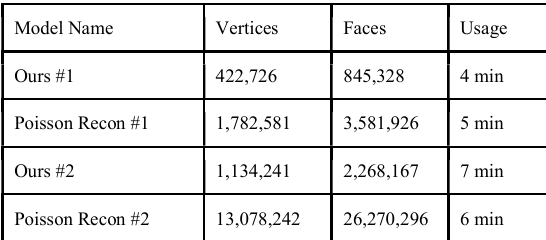
Table 1. Number of vertices of the reconstructed mesh and the processing